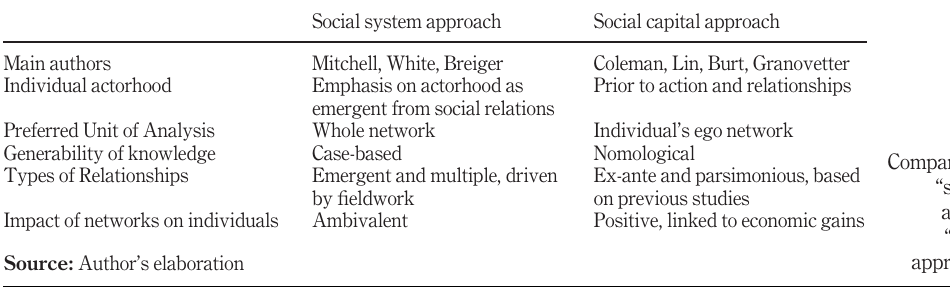
Table I. Comparison